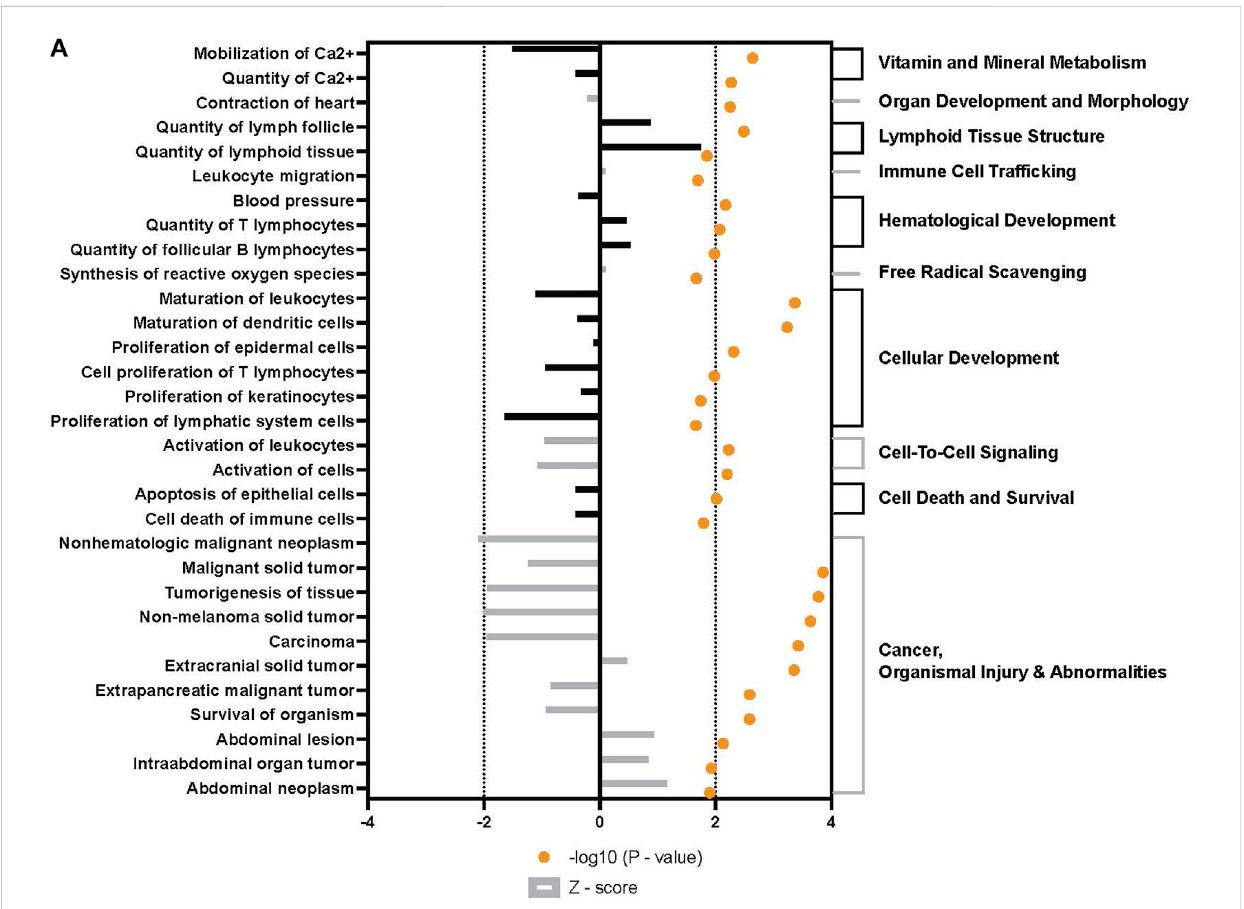
FIGURE 3 Downstream trends analysis of differentially expressed genes in hASCs post microbial challenge. The IPA regulation z-score algorithm was used to identify biological functions expected to increase or decrease based on the gene expression changes described in our dataset. Predictions base on p -value and z-score; positive z-score implies an increase in the predicted function, a negative z-score a decrease (z-score ≥ 2 or ≤ − 2 represented by black dotted lines). p -values ≤ 0.05 (orange dots determined by Fischer ’ s exact test), illustrate a signi fi cant association between a given biological function and genes differentially expressedin ourdataset ( p -value ≤ 0.05). p -values are presented as log-transformed. Shapes associated with each gene name and broad category indicate the general classi fi cation of the gene product, enzyme, growth factor,